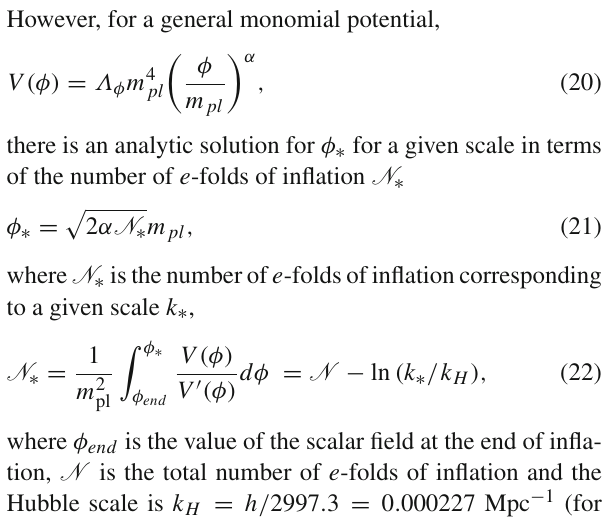
4 χ 2 Fit to the CMB Wehavemadeastraightforward χ 2 minimizationtofittheTT CMB Planck powerspectrum[14]forthe (cid:2) ∗ = 2and (cid:2) ∗ ≈